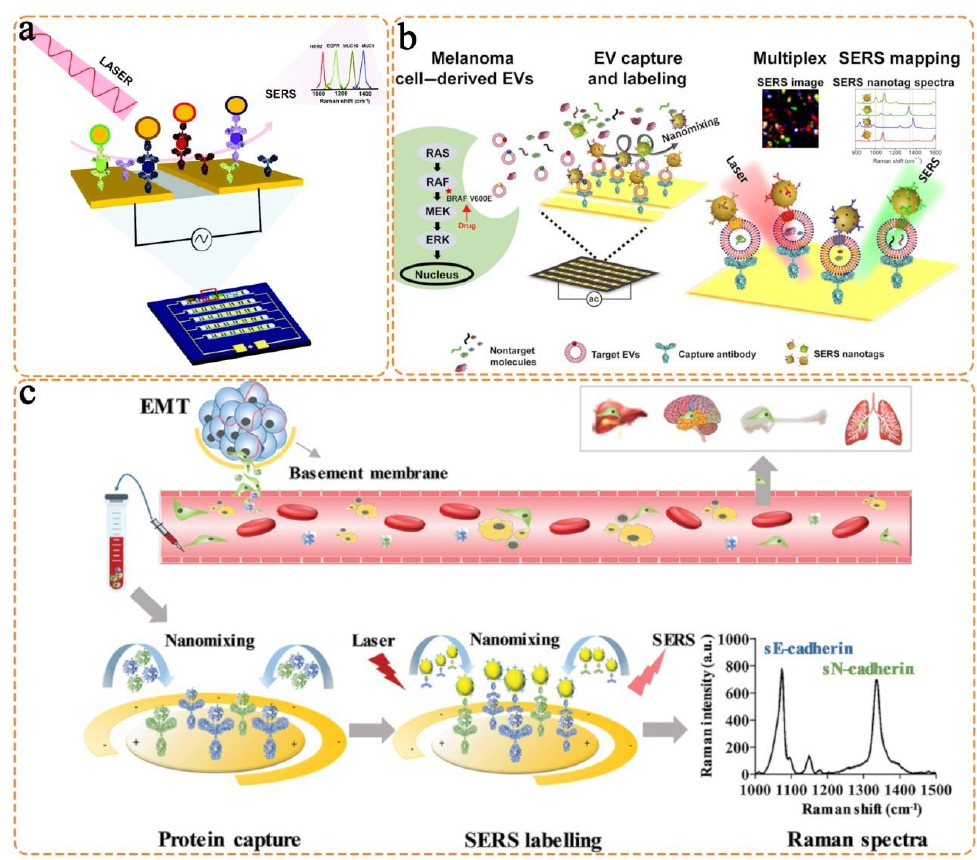
Figure 4. Integration of gold nanosphere-based SERS nanotags with microfluidic systems for multi-biomarker detection. ( a ) Detection of four circulating protein biomarkers (i.e., HER2, EGFR, MUC16, and MUC1). Reproduced with permission [46]. Copyright 2017, Wiley-VCH. ( b ) Profiling of